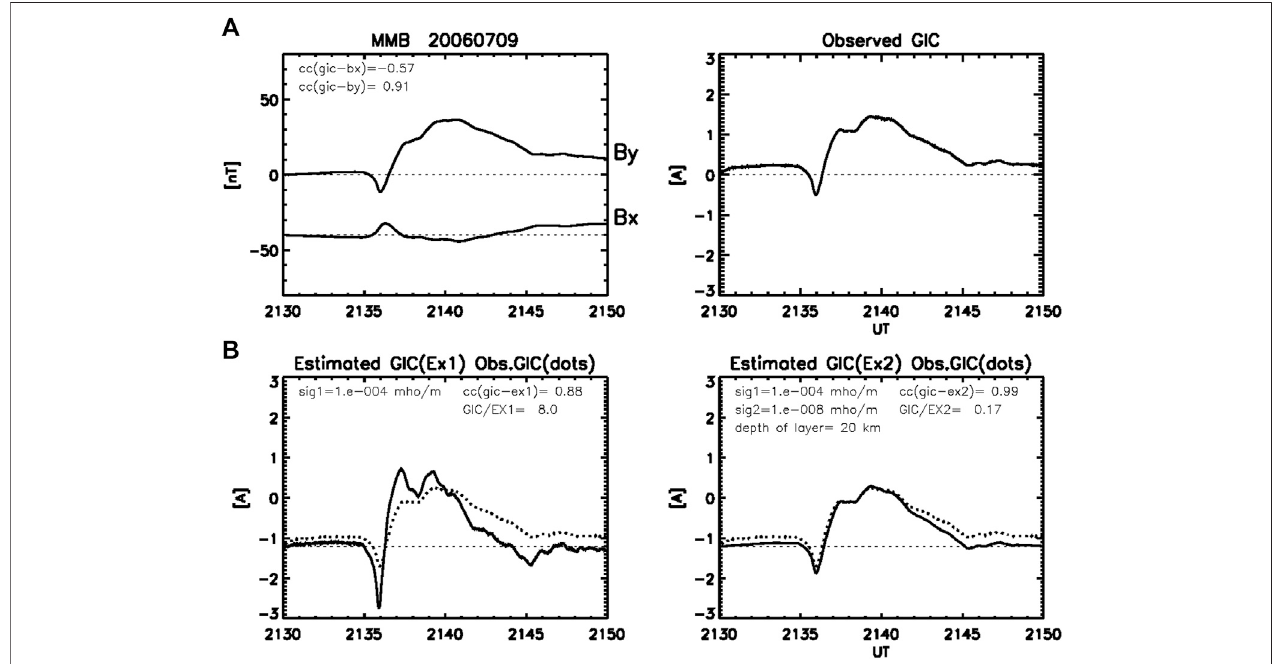
FIGURE 9| (A) B x , B y and GICobserved at MMB during the SC event same asin Figure 2 . (B) GIC estimated from E x1 and E x2 scaled with the same scale factors as in Figure 8 .